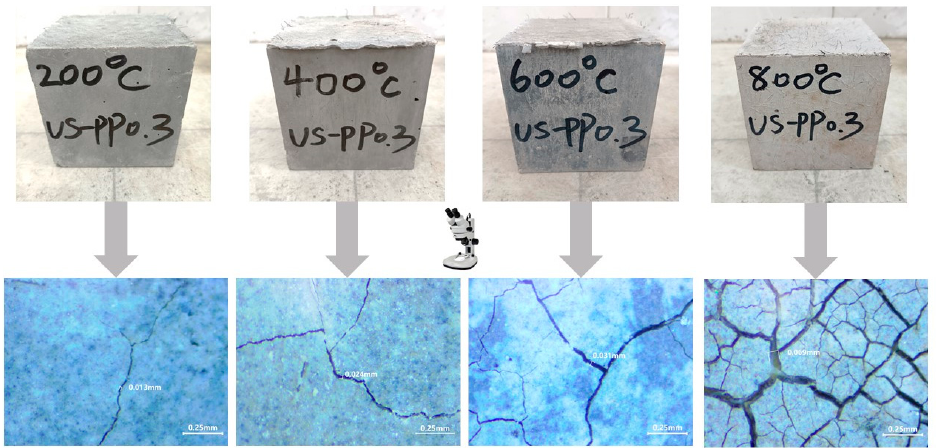
Figure 5. Surface crack conditions after exposure to high temperatures. After exposure to elevated temperatures, the concrete undergoes specific changes in its internal material composition and microstructure, resulting in varying degrees of changes in its quality [47]. The specimens were weighed after cooling to room tempera- ture. The variation curves between the mass loss rate of UHPC and temperature were measured for each group, as shown in Figure 6. The results were consistent with those of Sanchayan et al. [47] and Gong et al. [48]. Above 200 °C, the mass loss was not significant, with an average loss rate of 1.04%, which is less than 2%, with the lowest loss rate of 0.41% for the US and the largest for the single-doped synthetic fibers (UN and UP), which were 1.31% and 1.69%, respectively. The main mass loss in this temperature section is due to the evaporation of moisture, along with the melting or softening of synthetic fibers. Above 400 °C, the mass loss was pronounced, with an average loss rate of 5.33%; the lowest was 3.62% for the US, and the highest was 6.44% for the UP. This occurred because the com- bined water in hydrated products such as C-S-H gels starts to decompose in sequence, which makes more water escape from the interior. At the same time, the softened or mol- ten synthetic fibers also undergo melting and evaporation. Above 600 °C and 800 °C, the mass loss continued to increase with an average loss rate of 7.54% and 9.04%, respectively, and the UP remained the highest. The loss within this temperature range is mainly at- tributable to the internal CaCO 3 , Ca(OH) 2 and other materials that continue to decompose, along with the chemically bound water that is continuously lost. Figure 6. M as s loss after exposure to high temperatures.